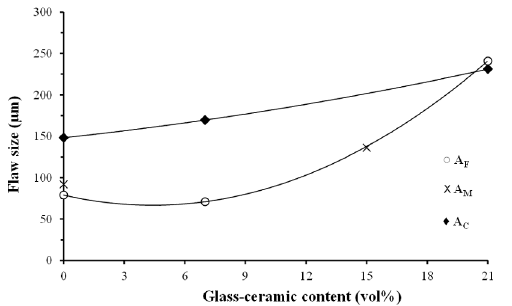
Figure 7. Calculated natural defect size in function of LZSA content of the alumina ceramics and LZSA/alumina composites.